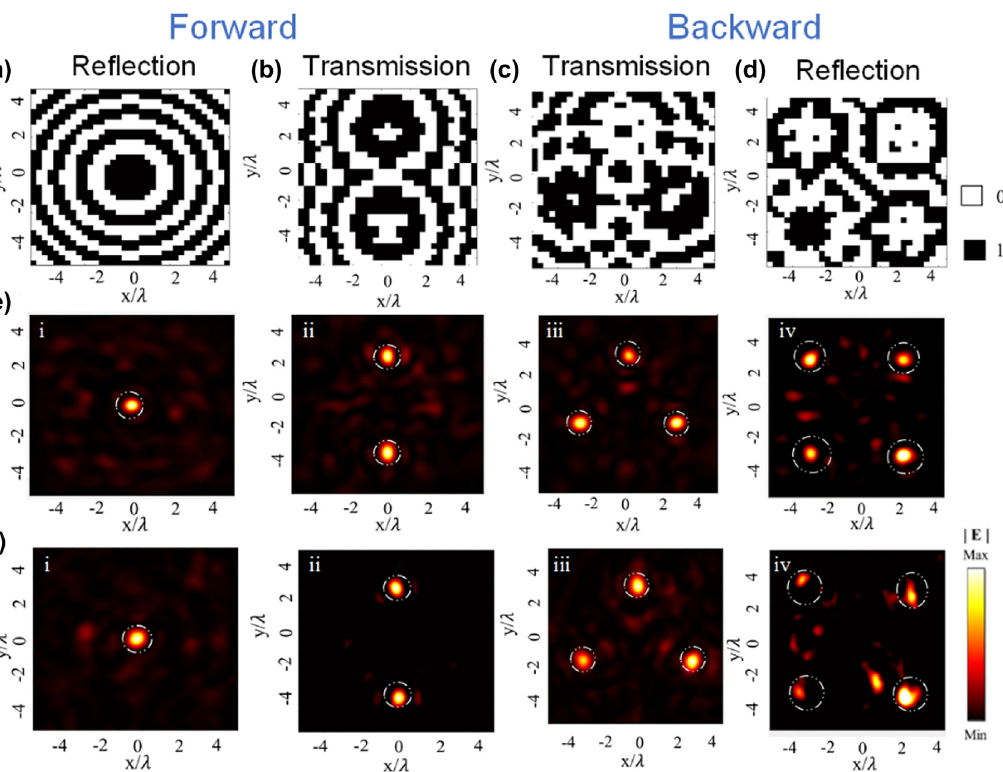
Figure 4: Characterization for the reflection and transmission multichannel focusing metasurface. The metasurface with overall dimensions of 279 × 279 mm 2 in the xoy plane is composed of 31 × 31 unit cells. (a) and (b) Phase distribution of the co-polarized reflected and cross-polarized transmitted channels for the linearly polarized forward incident wave. (c) and (d) Phase distribution of the cross-polarized transmitted and co-polarized reflected channels for linearly polarized backward incident wave. (e) Electric field distribution of corresponding simulation results in each channel. (f) Electric field distributions of corresponding experimental results in each